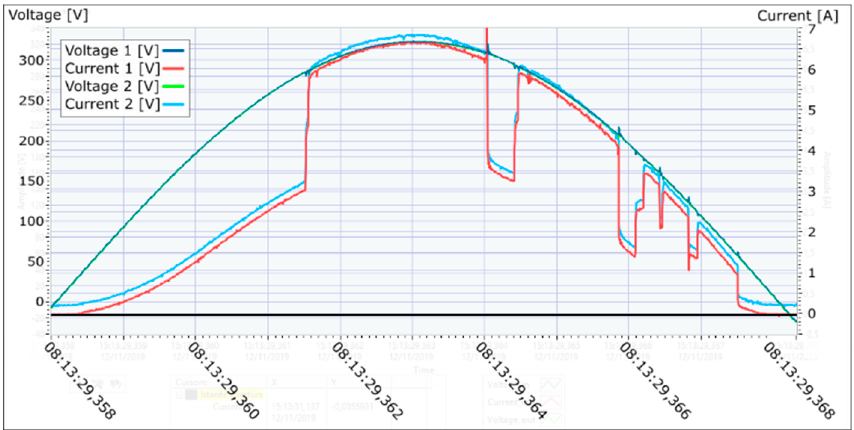
Figure 9. Deformation of the arc (using the Bourns 2049-09 surge arrester).